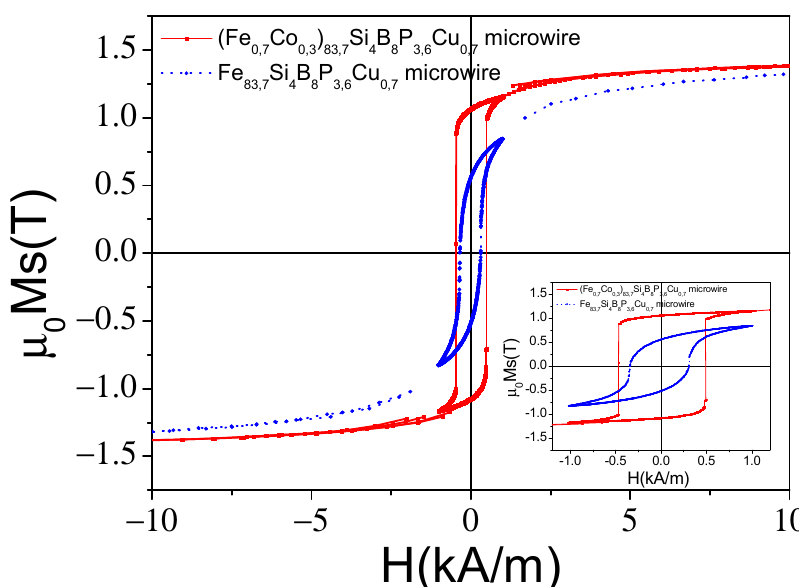
Figure 25. Hysteresis loops of studied (Fe 0.7 Co 0.3 ) 83.7 Si 4 B 8 P 3.6 Cu 0.7 and Fe 83.7 Si 4 B 8 P 3.6 Cu 0.7 (prepared for comparison) microwires as indicated. (Reproduced with permission from [109] Copyright © 2020 Elsevier B.V).